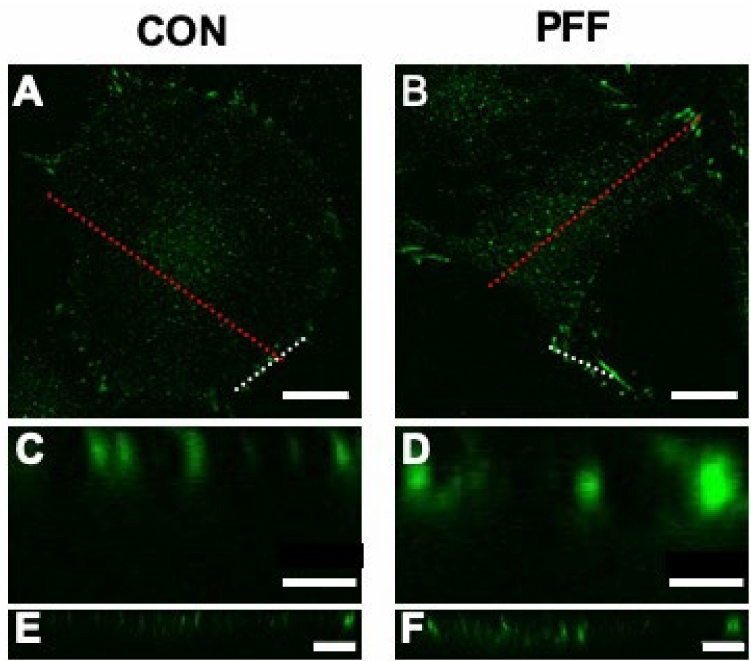
Figure A1. Focal adhesions visualized by staining of paxillin in MC3T3-E1 cells cultured without or with 1 h PFF. Line tool (Image J) was used to draw the target area. The “Reslice” function was used, and